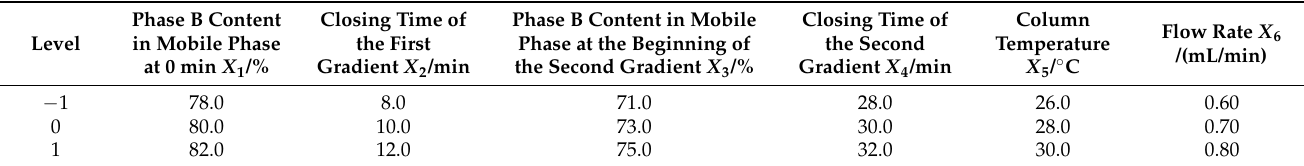
Table 2. Factors and levels of